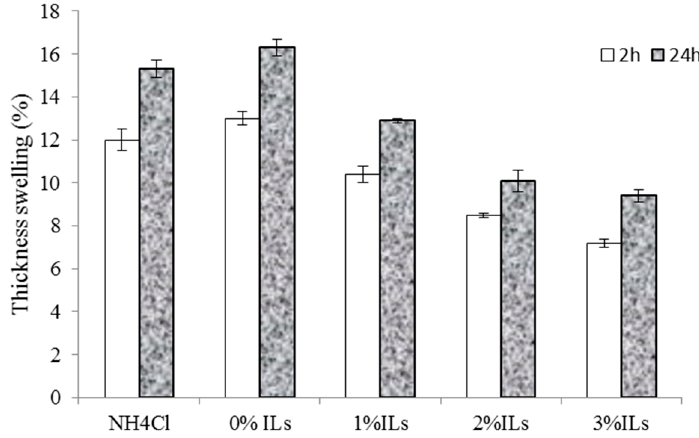
Figure 8. Thickness swelling of the manufactured panels made from synthesized resins.